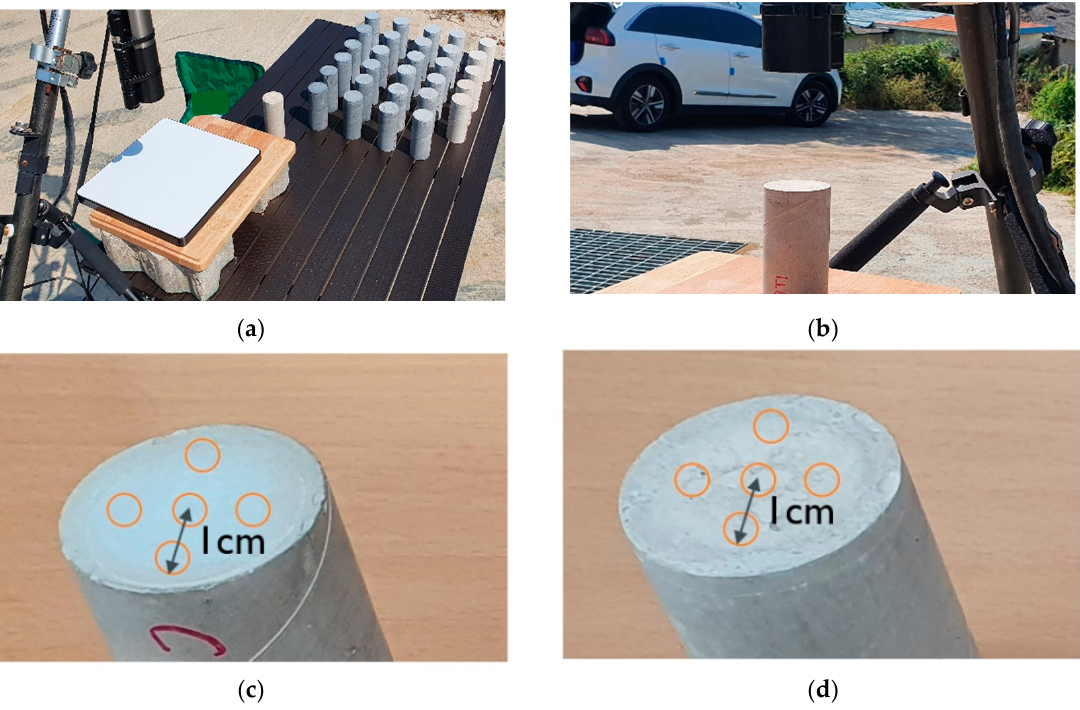
Figure 5. Setting of TriOS RAMSES sensors for the sample reflectance measurement ( a , b ), and the five locations of the measurement points on ( c ) the top face of the specimen, and ( d ) the bottom face of the specimen.